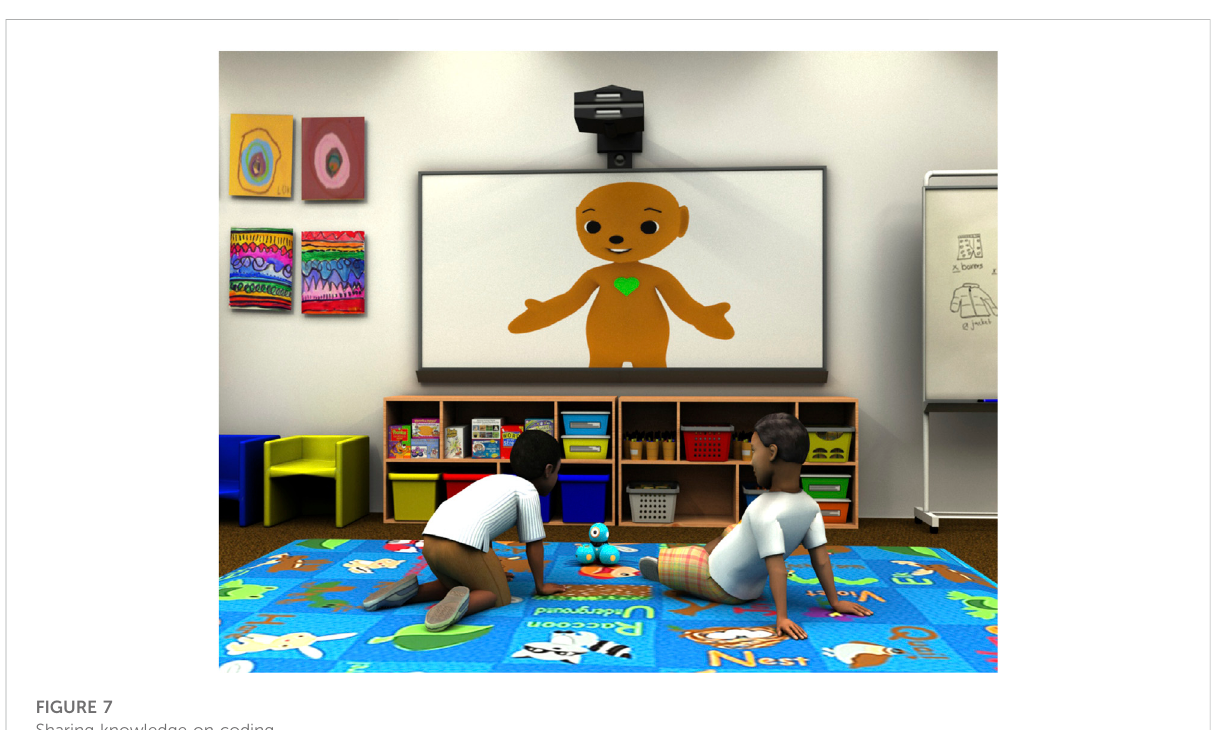
FIGURE 7 Sharing knowledge on